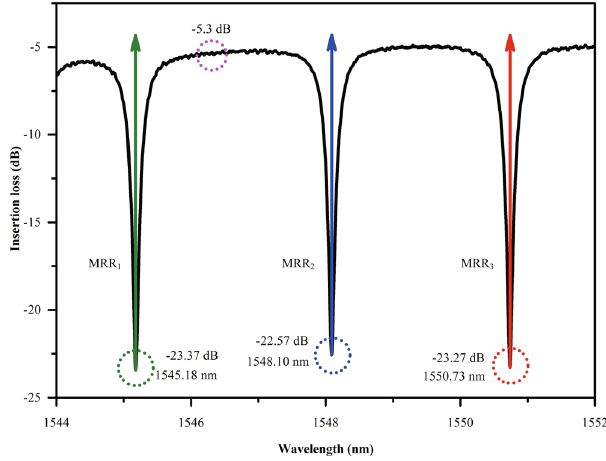
Figure 4. Static response spectral of the device with no voltage applied to MRRs.